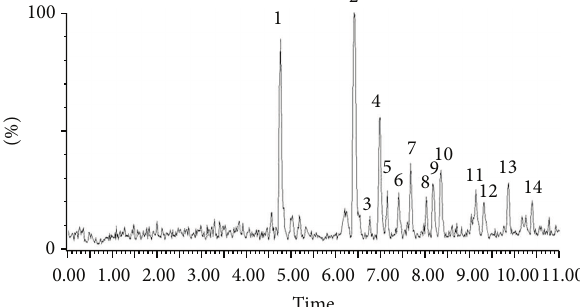
Figure 1: LC Chromatogram of ethanolic extract of Pueraria